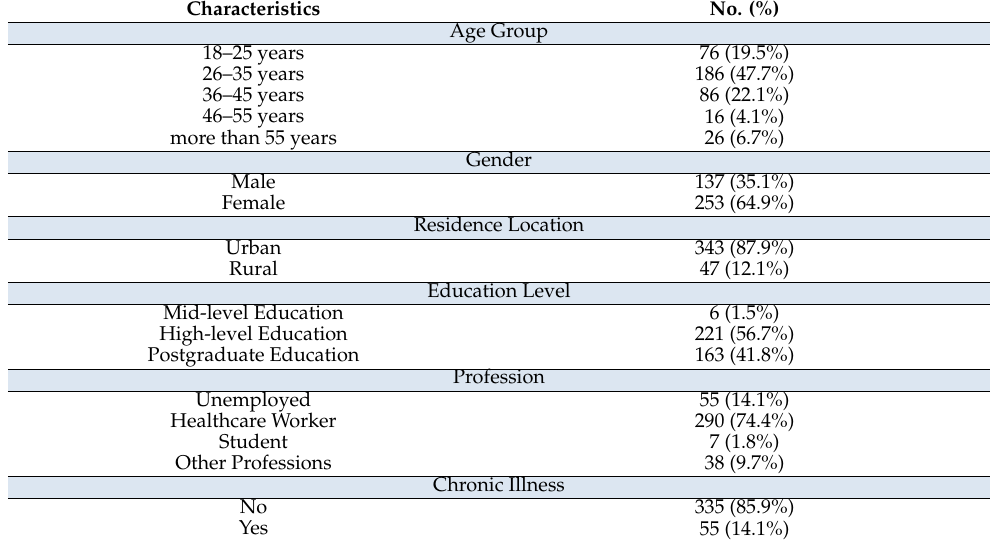
Table 1. Participants’ demographics.